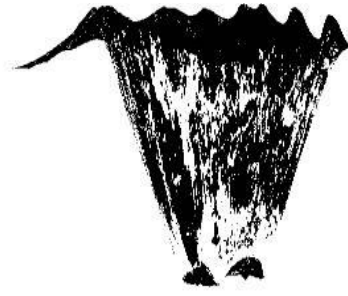
Figure 6. Effect picture of titanium content in impact crater,